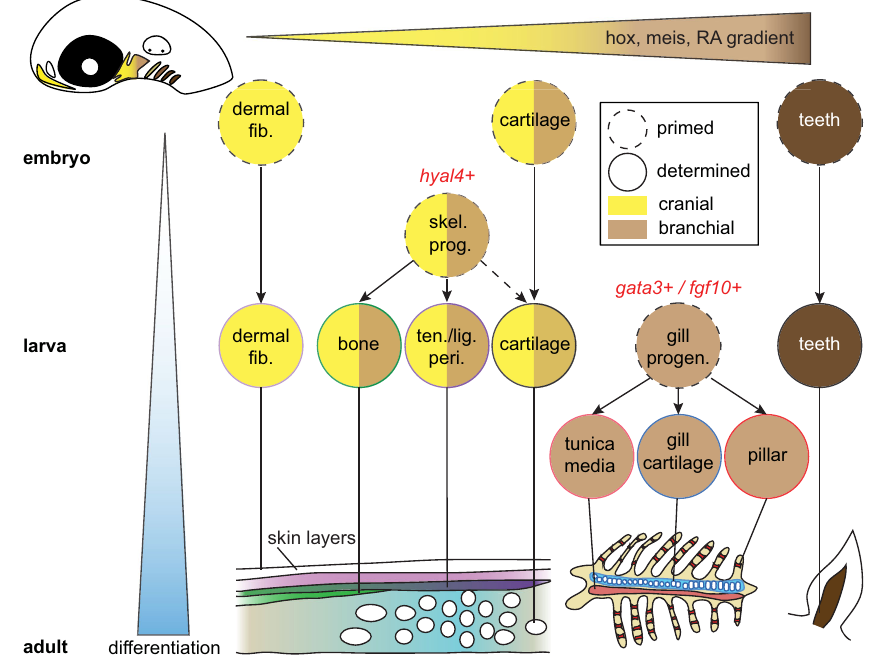
Fig. 7 Model of ectomesenchyme lineages of CNCCs. Cell types progressively emerge at distinct positions along the anterior-posterior axis of the developing head. Time is represented along the y -axis from young (white) to old (blue). Positional information is represented along the x -axis from anterior (yellow) to posterior (brown). Cell types are denoted by circles, with skeletal progenitors distinguished by hyal4 expression and gill progenitors by gata3 and fgf10 gene expression. Mature cell types are schematized at the